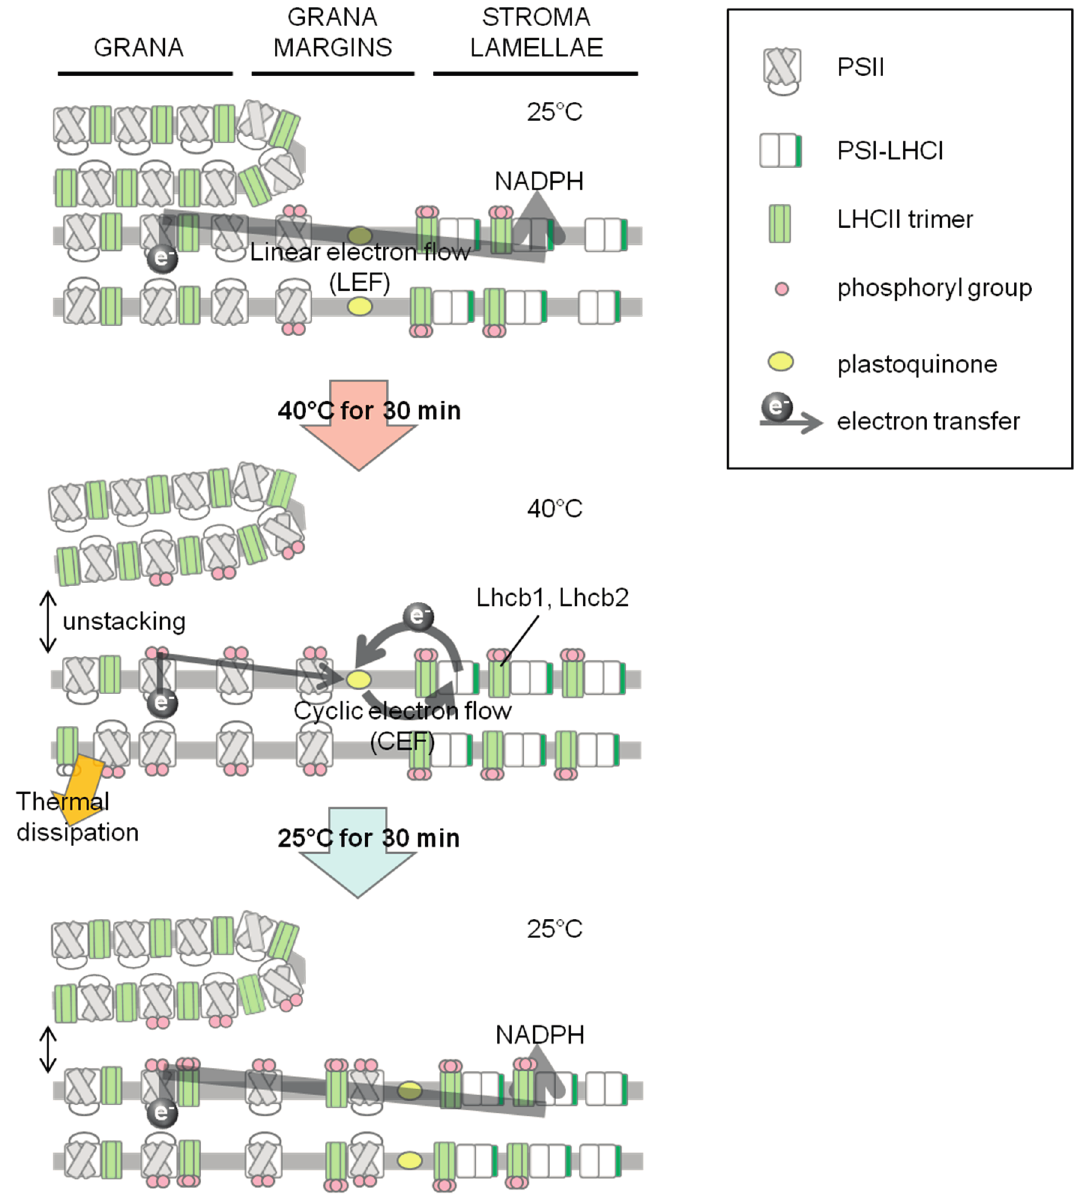
Figure 5. Schematic diagram of the thylakoid membrane and electron flow under different temperature conditions. Upper panel, at 25 °C in the light, the linear electron flow (gray arrow) is the primary pathway although most of LHCII is associated with PSI, and the thylakoid membrane is stacked; Middle panel, under heat-stressed condition at 40 °C in light, LHCIIs and PSII core subunits are phosphorylated. PSI, which is associated with phosphorylated LHCII trimers is preferentially excited and enhances cyclic electron flow (CEF) (gray bold arrow) to avoid over-reduction of PQ. Acidification of lumen by CEF (black arrow) induces PSII thermal dissipation (orange arrow), which restricts linear electron flow (gray thin arrow); Lower panel, recovery from heat stress, LHCIIs and PSII core subunits remain phosphorylated, and the thylakoid membranes are not rigidly